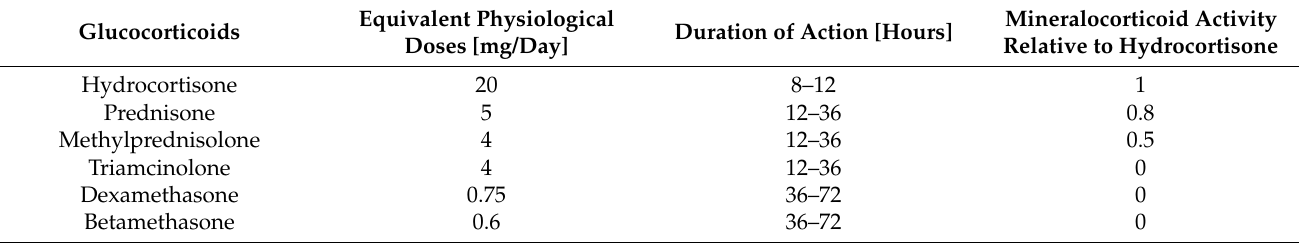
Table 1. Characteristics of glucocorticoid